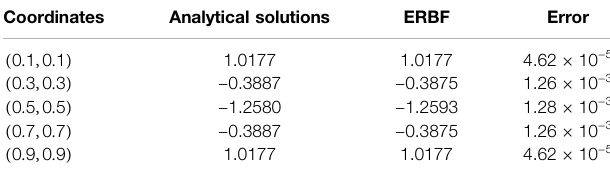
TABLE 1 | The comparison of the absolute errors at t (cid:2) 0.5 s. Coordinates Analytical solutions